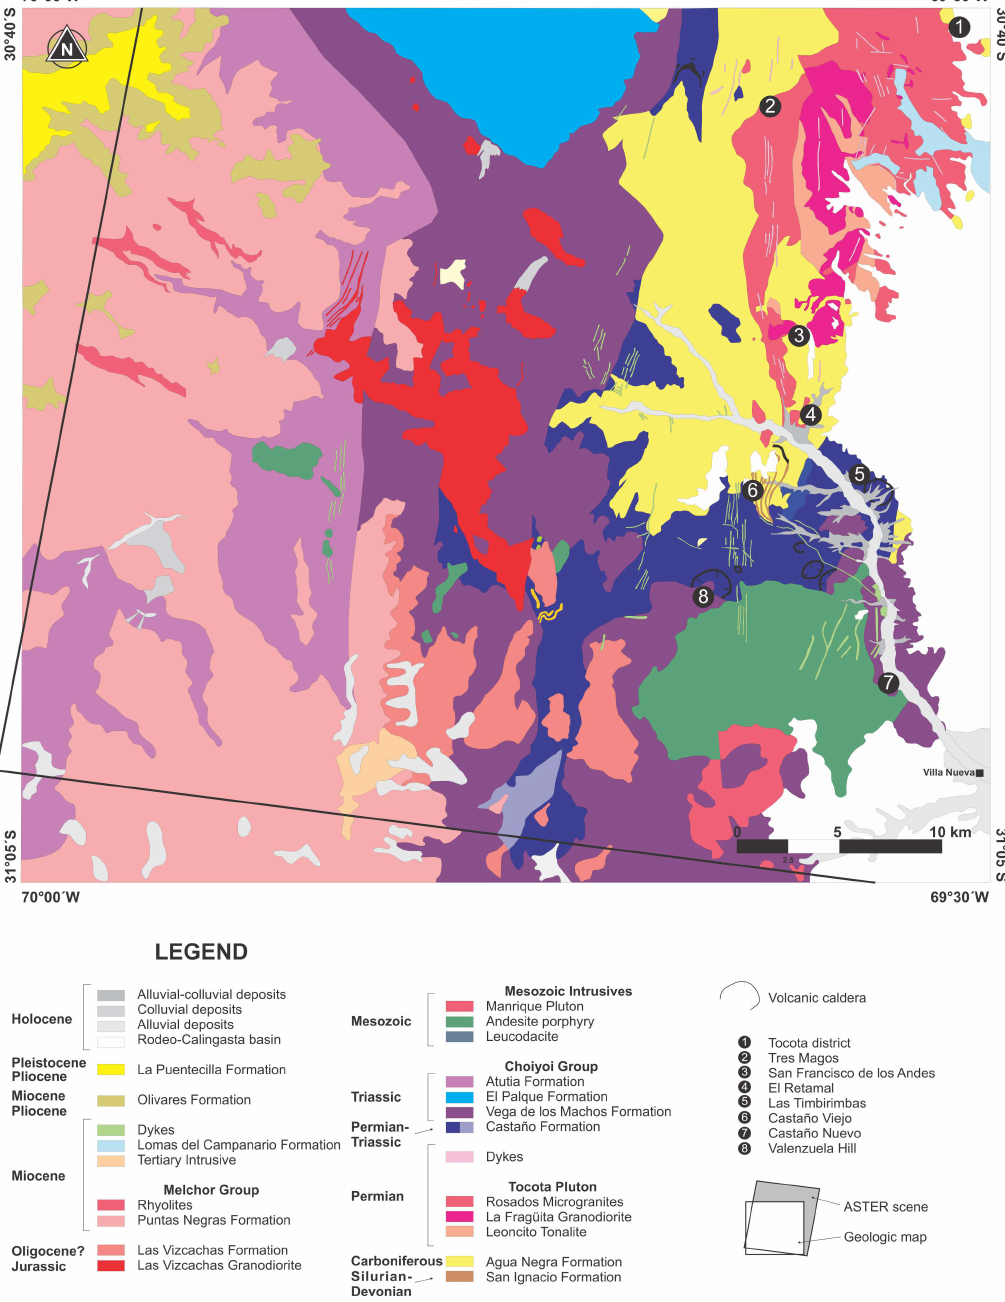
Figure 3. Geologic map of the study area [21]. This map has been drawn based on the available geologic maps [26,28,30,32] and field verification across the San Francisco de los Andes